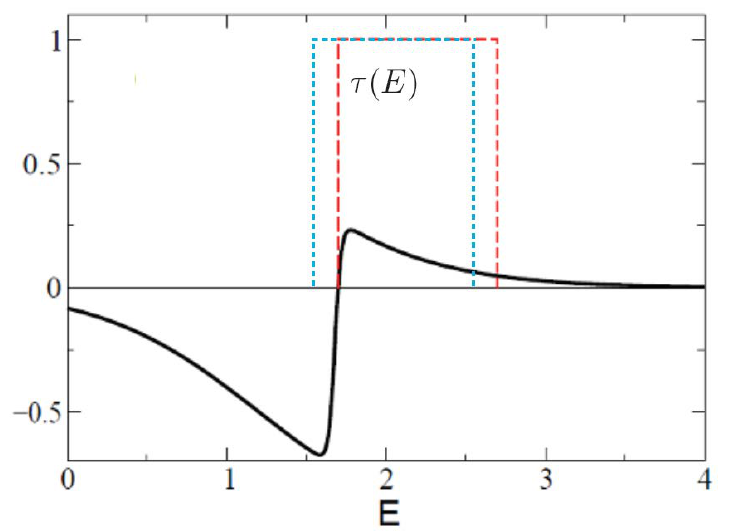
Figure 2. Optimizing transmission function τ ( E ) in the nonlinear regime. Difference of the Fermi functions F ( E ) = f H ( E ) − f C ( E ) (solid black curve) with T H = 0.5, µ H = 1.0, µ C = 1.68, and ˆ E = 1.7 and two identical width square-wave transmission functions τ ( E ) , one (blue) starting at energy < ˆ E and a second one (red) starting at E R = ˆ E E B 0 0